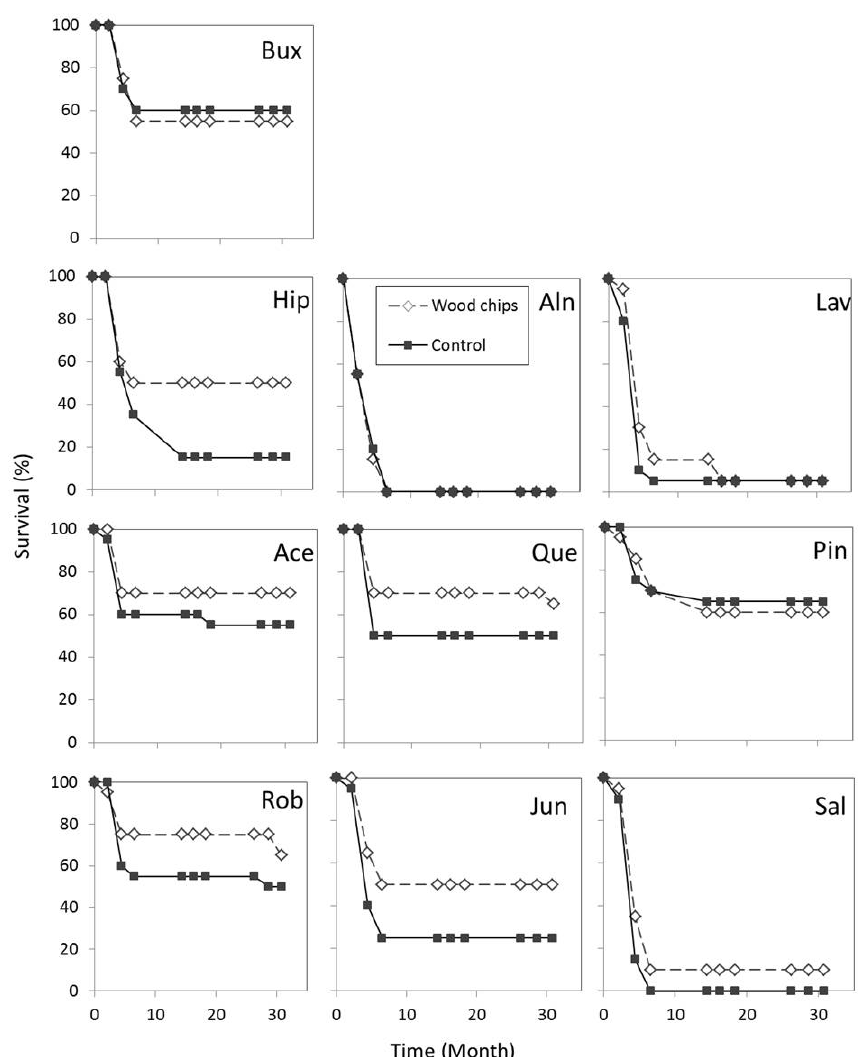
Figure 5. Plant experiment: comparison of survival rates between “wood chips” and “control” modalities, for three growing seasons after planting (see species abbreviations in Table